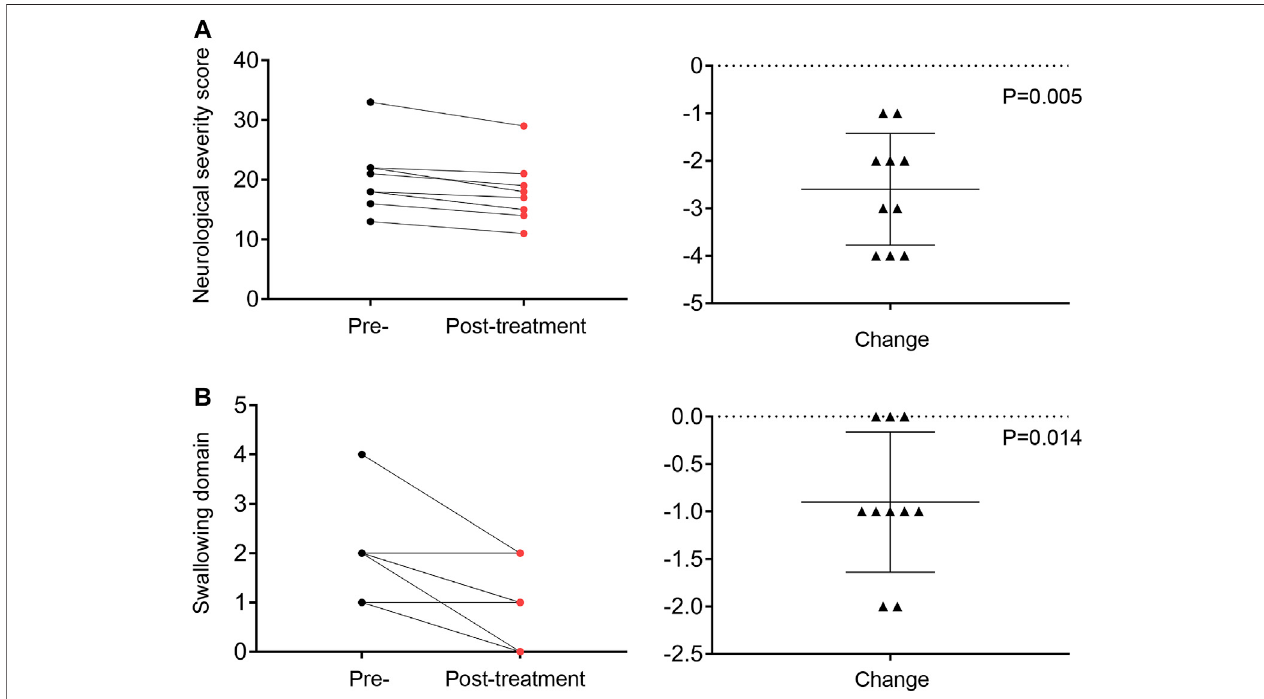
FIGURE 5 | The total NNSS (A) and swallowing (B) domain score recorded at the pre-study and 12-months visits. Change in total score and swallowing domain score from the pre-study to the fi nal visit assessment.